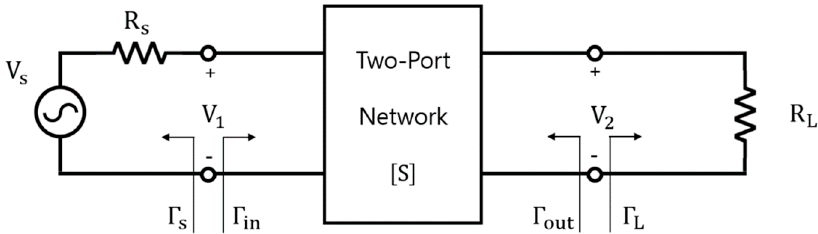
Figure 6. Block diagram of two-port network [16].